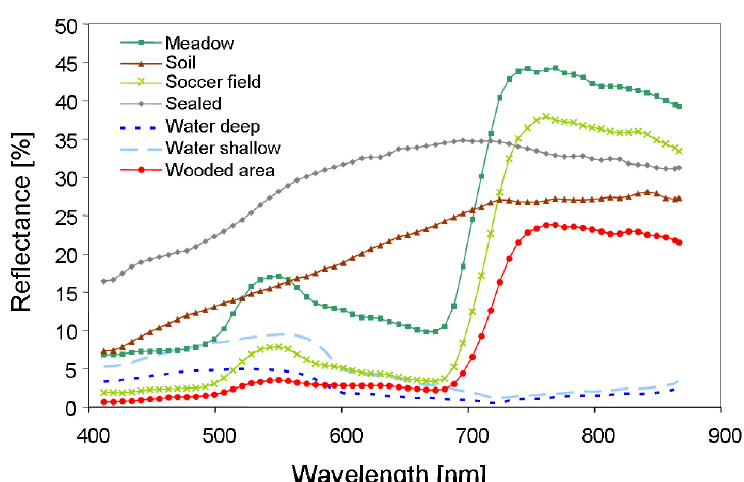
Figure 14. AVIS-2 reflectance spectra from the data shown in Figure 13